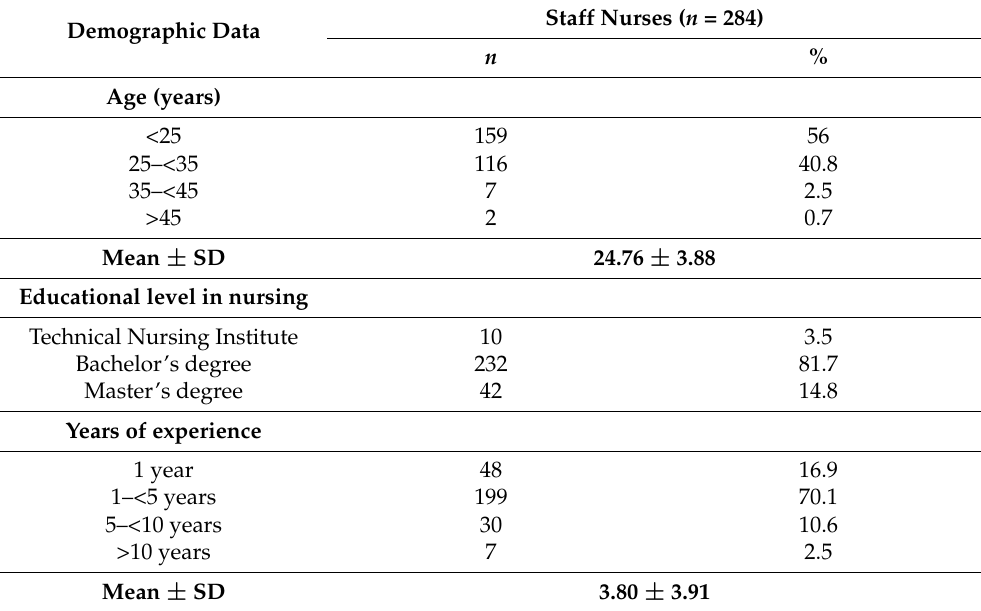
Table 2. Demographic data of studied staff nurses ( n =